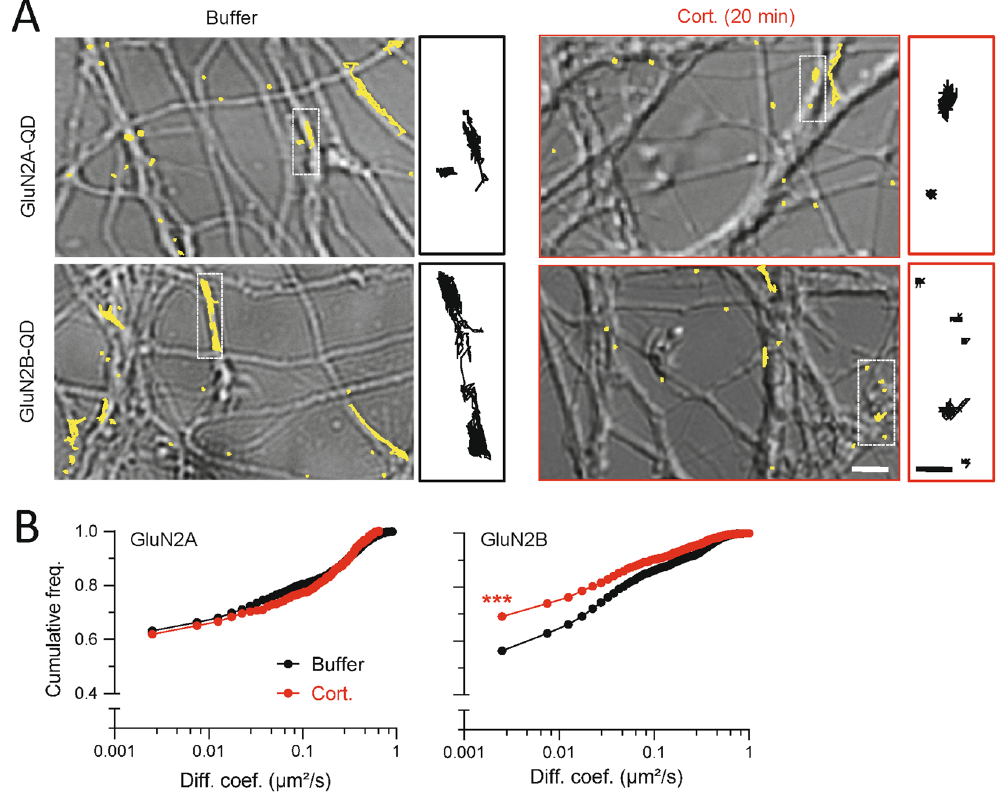
Figure 4. Corticosterone specifically decreases the surface dynamics of GluN2B-NMDAR in hippocampal neurons exposed to corticosterone. ( A ) Representative trajectories of single GluN2A- and GluN2B-NMDAR in hippocampal neurons (DIC images) exposed to either buffer or corticosterone (100 nM, 20 min). Scale bar, 5 µ m; scale bar inset, 1 µ m. ( B ) Comparison of the cumulative distributions of GluN2A- (buffer, n = 112 trajectories; corticosterone, n = 143 trajectories) and GluN2B-NMDAR (buffer, n = 189 trajectories; corticosterone, n = 191 trajectories) instantaneous diffusion coefficients in buffer and corticosterone conditions. *** p < 0.001, Kolmogorov-Smirnov